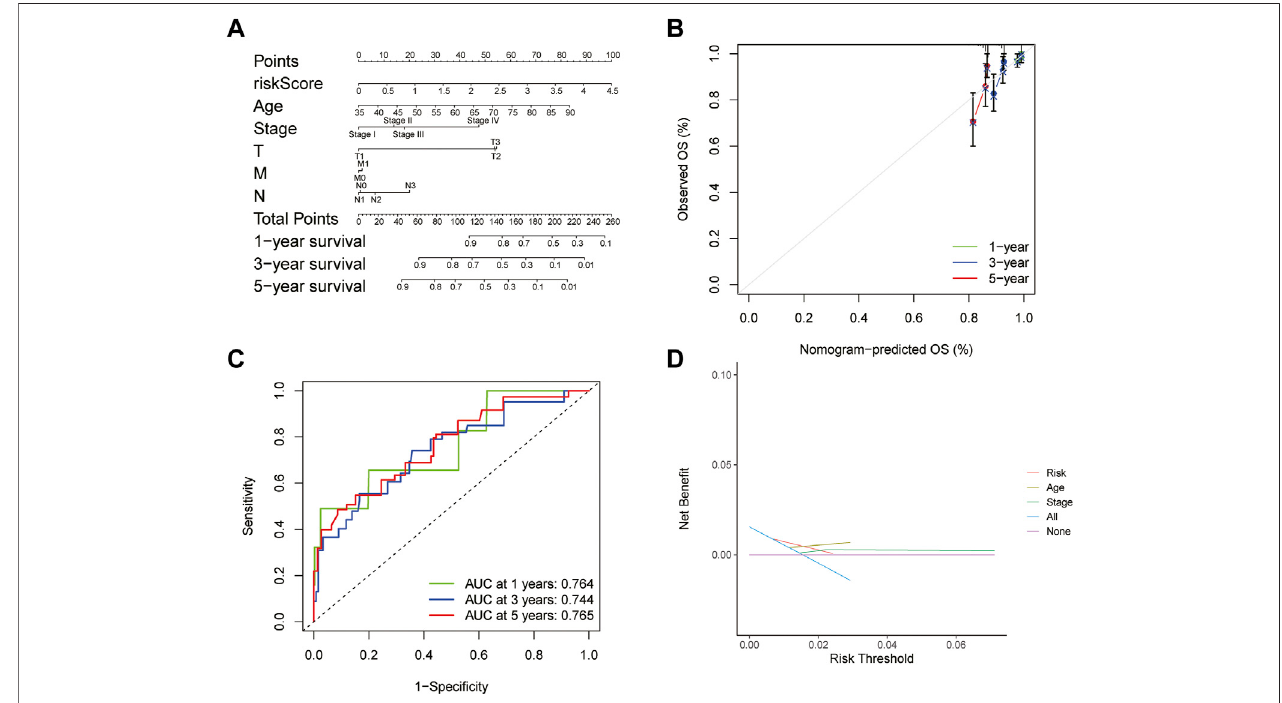
FIGURE 6 | Construction and evaluation of nomogram (A) Nomogram for predicting the 1-, 3-, and 5-year survival rates based on the risk score (B) Calibration curveofthenomogram (C) ROCcurveanalysisevaluatedthepredictionperformanceofnomogram (D) Decisioncurvesof “ risk ” , “ age ” , “ stage ” , “ all ” and “ None ” models.